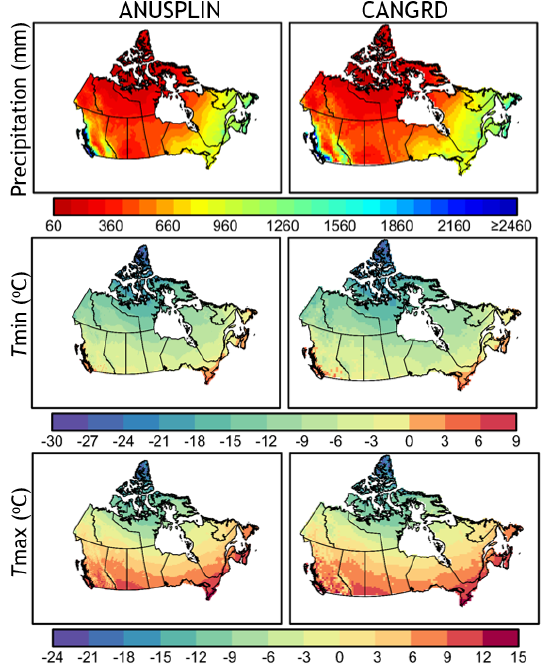
Figure 2. Mean annual climatology of precipitation, minimum tem- perature ( T min), and maximum temperature ( T max) for the period